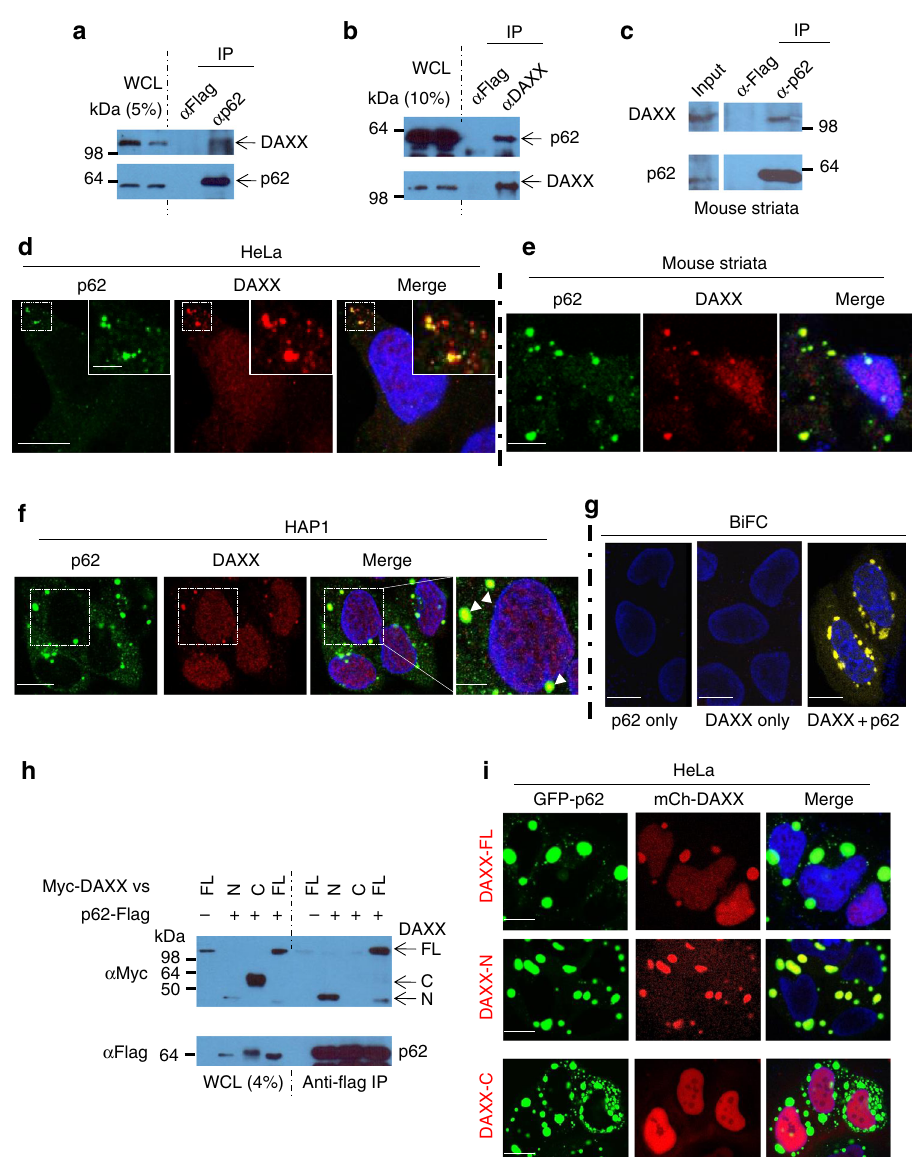
Fig. 1 Identi fi cation of DAXX as a p62-interacting partner. a Endogenous p62-DAXX interaction (p62 antibody pull-down). HeLa cell lysates were subjected to Flag antibody (negative control) and anti-p62 antibody immunoprecipitation (IP). The immunoprecipitates and the whole cell lysates (WCL) were probed with anti-DAXX and anti-p62. b Endogenous p62-DAXX interaction (DAXX antibody pull-down). HeLa cell lysates were subjected to Flag antibody (negative control) and anti-DAXX antibody IP. The immunoprecipitates and the WCL were probed with anti-p62 and anti-DAXX. c Mouse (8-week) striatal lysates were immunoprecipitated by Flag antibody or anti-p62 antibody. The immunoprecipitates and the WCL were probed with anti-DAXX and anti-p62. d Co-localisation of endogenous p62 and DAXX in HeLa cells. HeLa cells were immunostained with anti-p62 and anti-DAXX. Images were acquired with a confocal microscope. Bar: 10 µ m; bar (inset): 2 µ m. e Mouse (6-week) striatal sections were stained with anti-p62 and DAXX